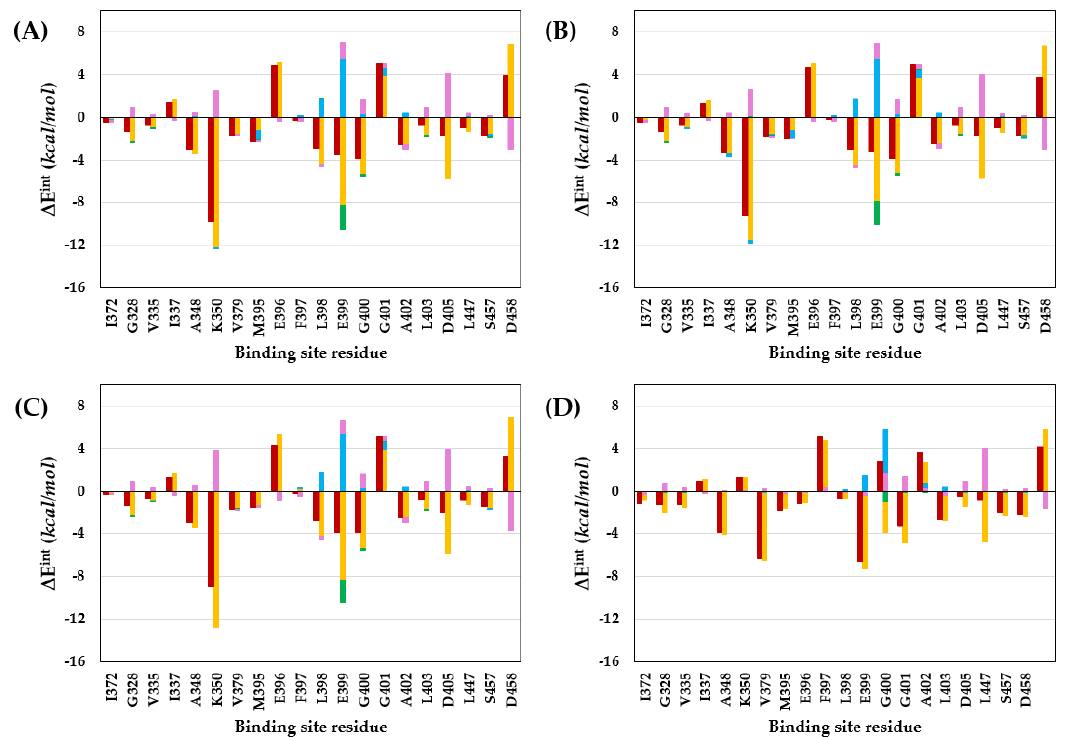
Figure 3. PIE calculated at the FMO. ( A ) compound 1, ( B ) compound 2, ( C ) compound 3, and ( D ) compound 4. In the graph, pair-interaction energy (E int ), electrostatic (E es ), exchange-repulsion (E ex ), charge transfer (E ct ), dispersion (E di ), and solvation energy are shown in red, yellow, sky blue, green, dark blue, and pink colors, respectively.